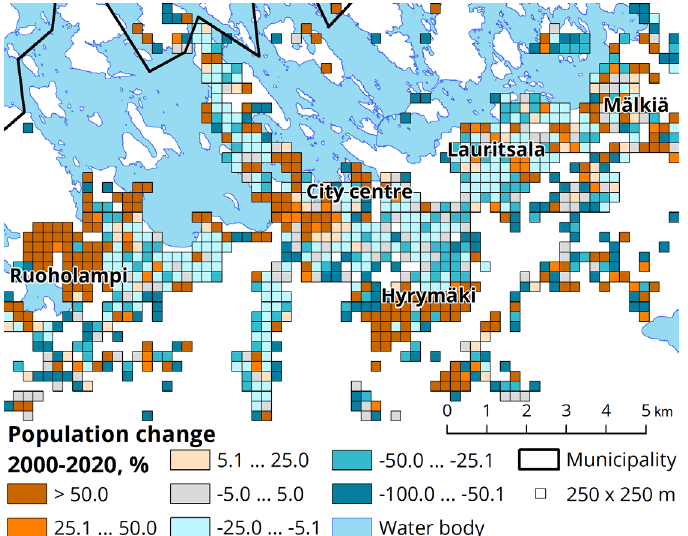
Fig. 7. An example of shrinking pockets at the grid level in terms of population (Lappeenranta